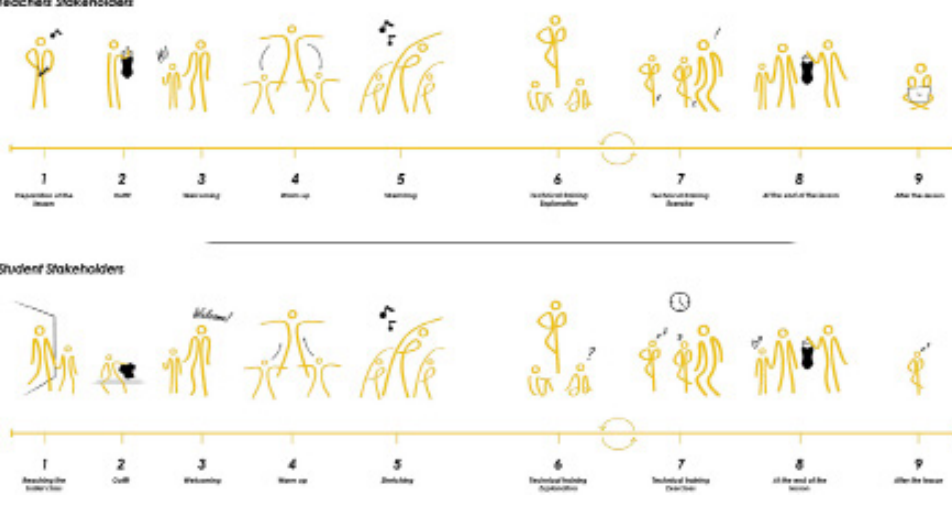
Fig. 13 Zambonini A., the User Journey Maps (UJM) of teachers and students highlights how a proper app development, covering the entire learning process as an educational game, is highly needed,